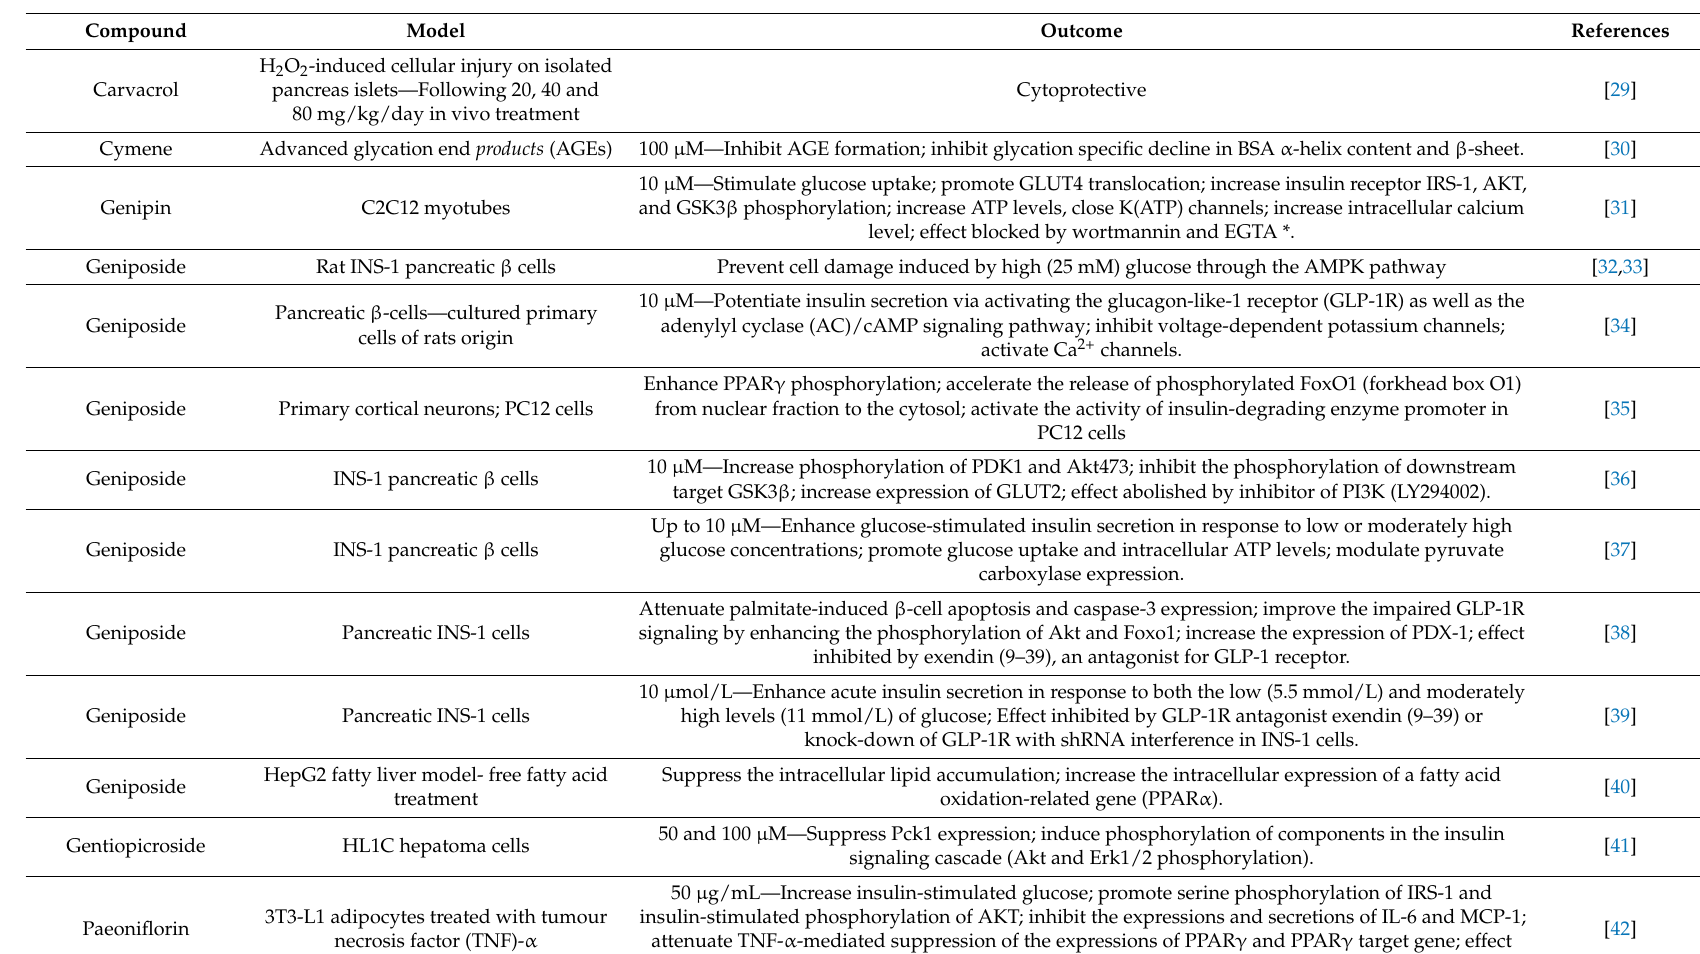
Table 1. In vitro antidiabetic effect of